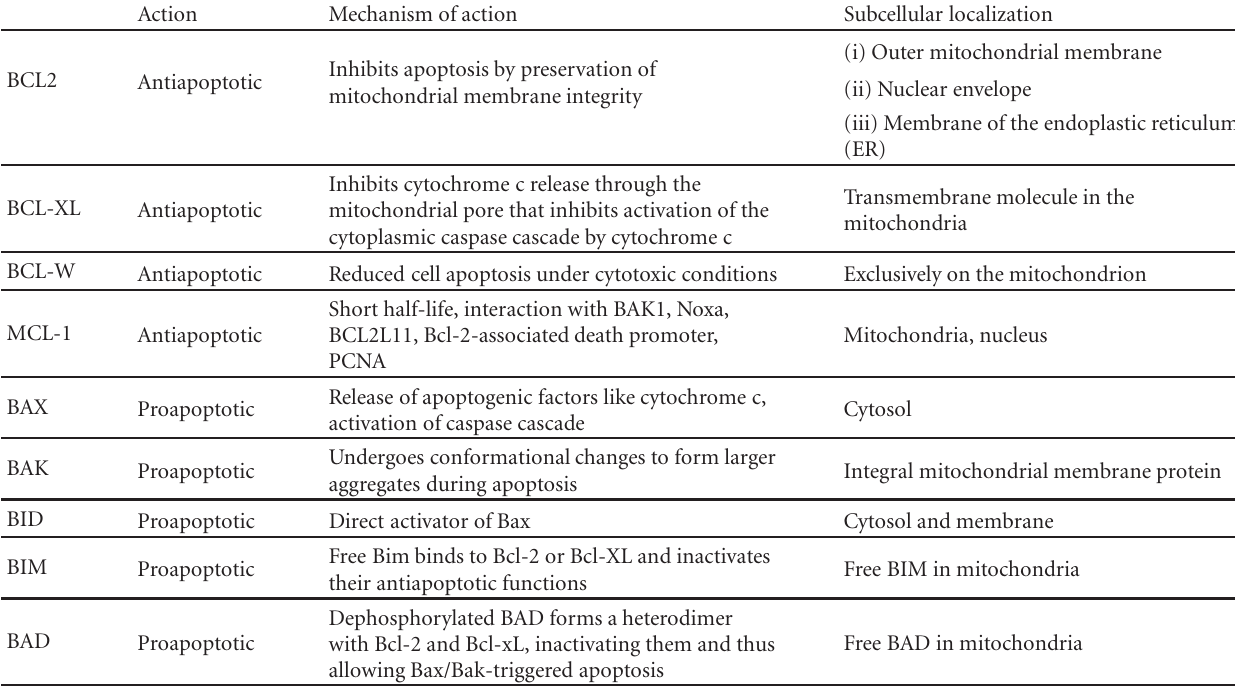
Table 2: This table summarizes the properties of the most well-studied members of BCL2